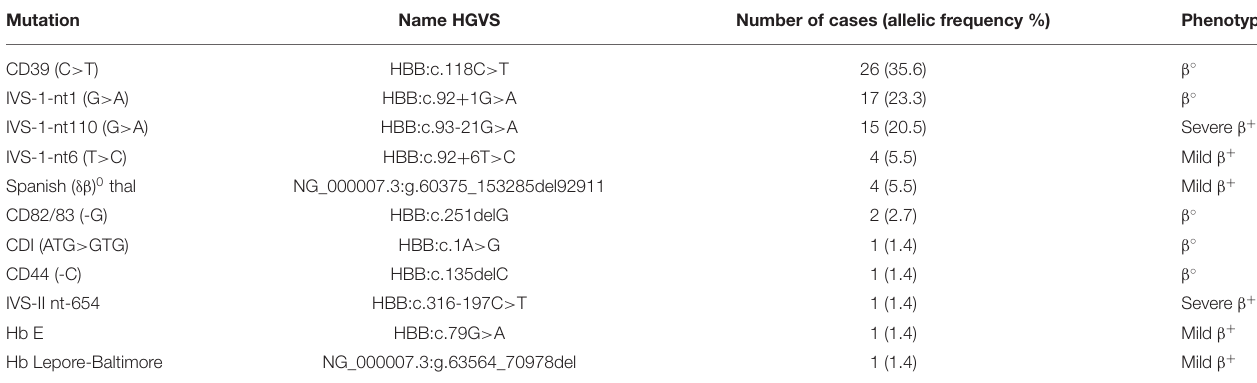
TABLE 2 | Mutations identified in the β -globin gene responsible for β -thalassemia.